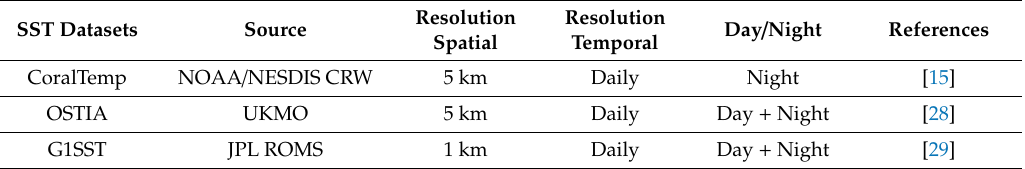
Table 2. Remote sensing datasets evaluated in this